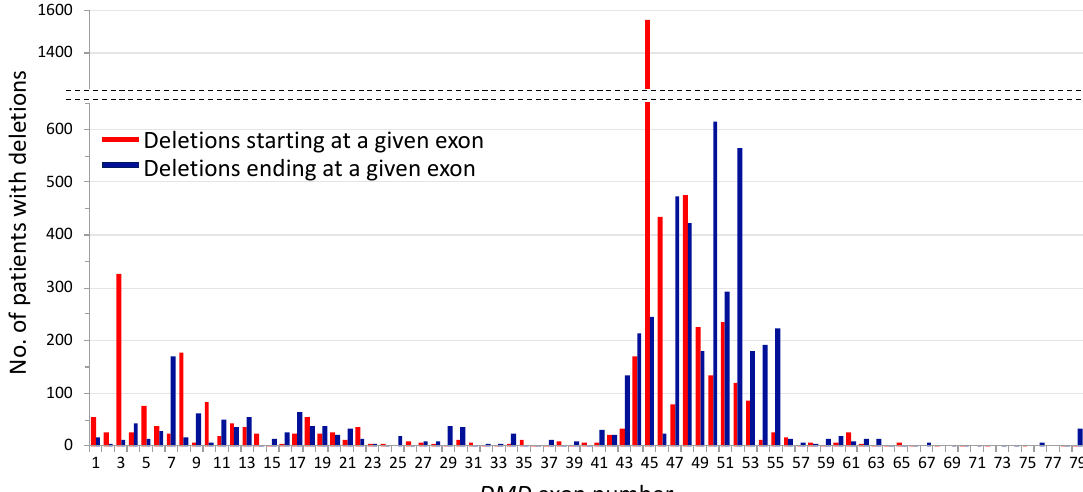
Figure 1. DMD hot spots of deletion mutations in the proximal (exons 1–22) and distal (exons 43–55) regions. The two hot spots were found using data from 4929 patients in the LOVD database (as of 22 June 2018) who harbor deletions starting or ending at a given exon; for example, the deletions of exons 45–XX such as exons 45–50 and 45–52 fall into the group of “deletions starting at a given exon” shown in red; exons XX–50 deletions such as exons 48–50 and 49–50 deletions come into the group of “deletions ending at a given exon” in blue. Individual deletion patterns found in the proximal and distal hot spots account for 0.5–6.6% and 2.7–12.5% of all the deletions, respectively; others account for less than 0.5%, except deletions involving exons 29, 30, 41, 61 and 79. Only deletions identified by Multiplex Ligation-dependent Probe Amplification (MLPA), Multiplex Amplifiable Probe Hybridization (MAPH), Array Comparative Genomic Hybridization (array CGH), Next Generation Sequencing (NGS), or a combination of multiplex PCR and Southern blotting were analyzed.